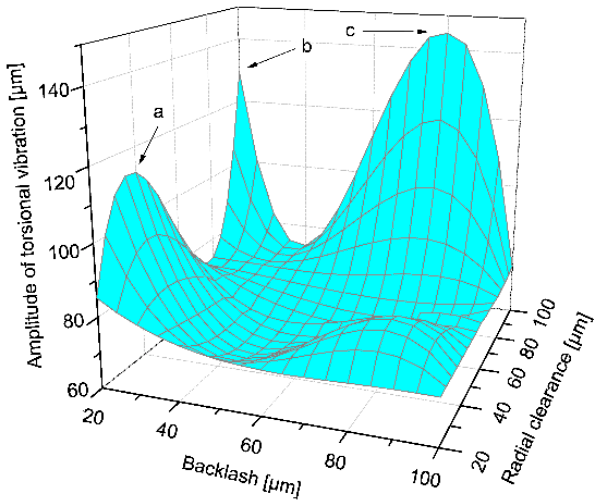
Figure 15. The amplitude of radial vibration for antenna reflector with different clearance size of planetary gear in pitch joint.